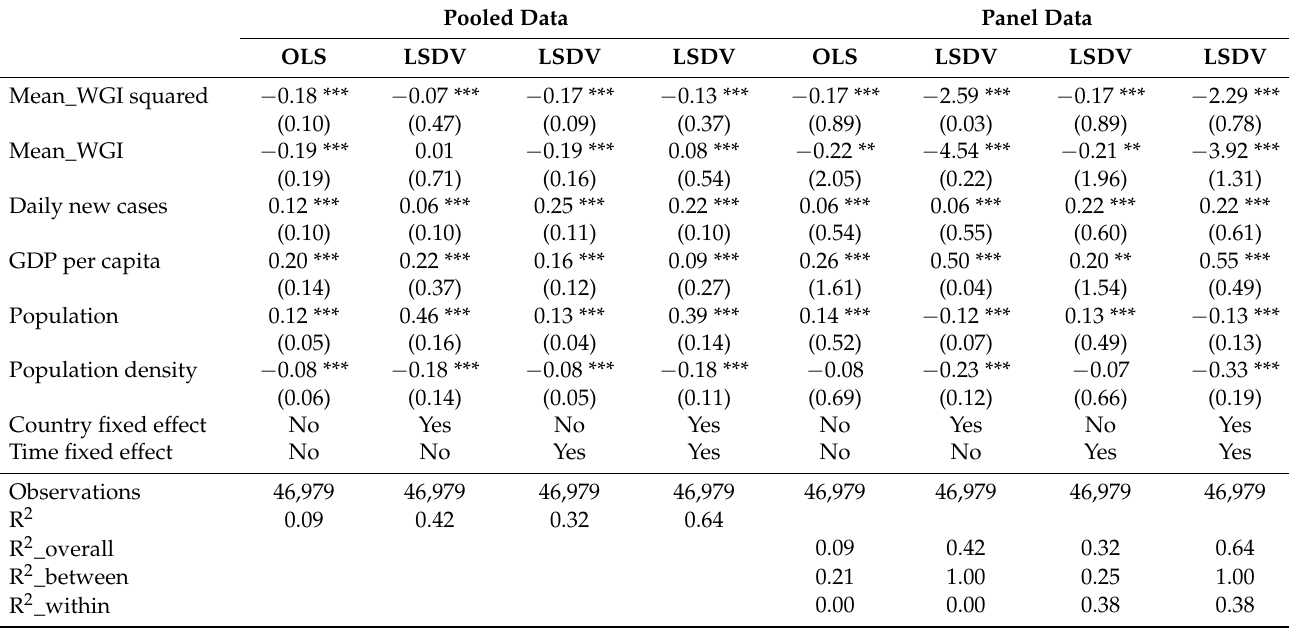
Table 5. Robustness checks: